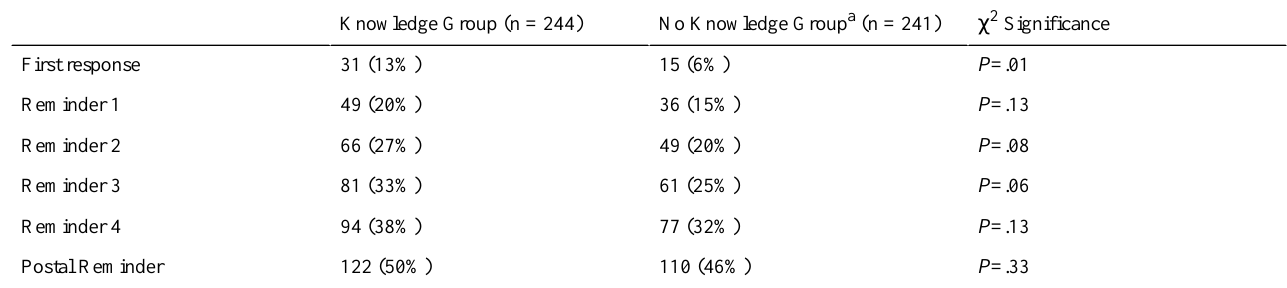
Table 1. Cumulative response over time by group